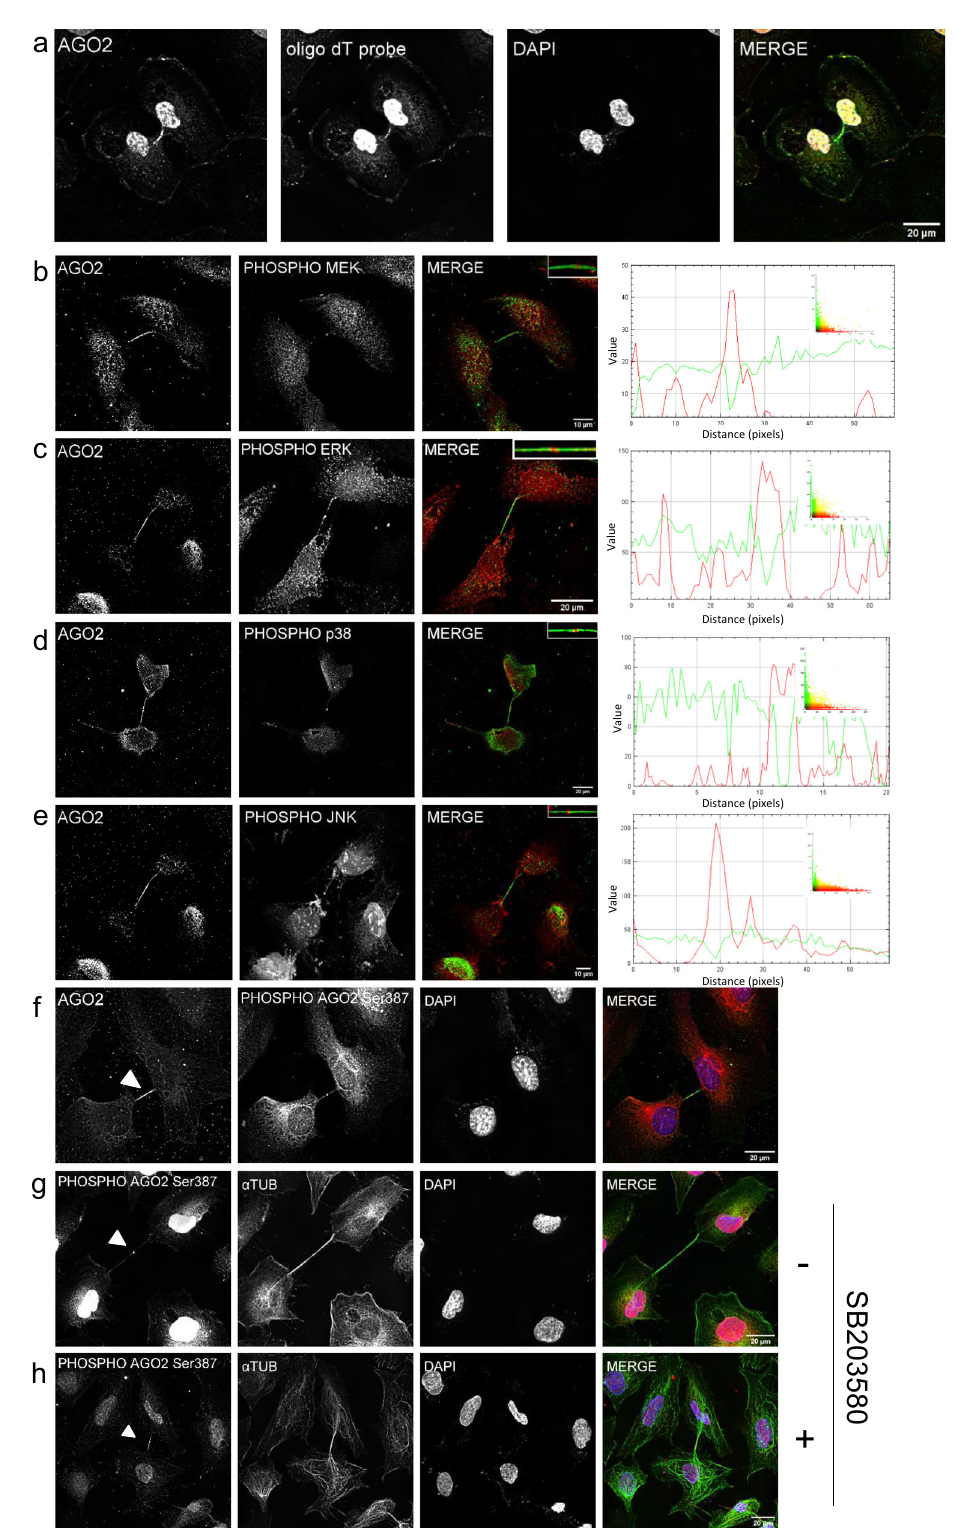
Fig. 8 Activated kinases follow the AGO2/Dicer distribution in the midbody structure. Representative images of NTHY ori 3-1 cells. AGO2 colocalization with a biotinylated oligo dT probe (scale bar: 20 μ m). Small kinome analysis of b AGO2-phospho-MEK (scale bar: 10 μ m), c AGO2-phospho-ERK (scale bar: 20 μ m), d AGO2-phospho-p38 (scale bar: 20 μ m), e AGO2-phospho-JNK (scale bar: 10 μ m). a – e AGO2 proteins were visualized in green, ο ligo dT probe, phospho-MEK, phospho-ERK, phospho-p38, and phospho-JNK were visualized in red. b – e Visual assessment (merged images, scatterplots, and intensity lineplots) of colocalization. b – e Lineplots indicate the signal intensity of the two paired proteins. Images of AGO2 colocalization with f phospho- AGO2 Ser 387 and phospho-AGO2 Ser 387 with α -Tubulin in g untreated and h treated cells with SB205380 p38 inhibitor. f – h Phospho-AGO2 Ser 387 in red, f AGO2 and g , h α -Tubulin in green, respectively. Nuclei were visualized in blue (DAPI). Scale bar: 20 μ m.